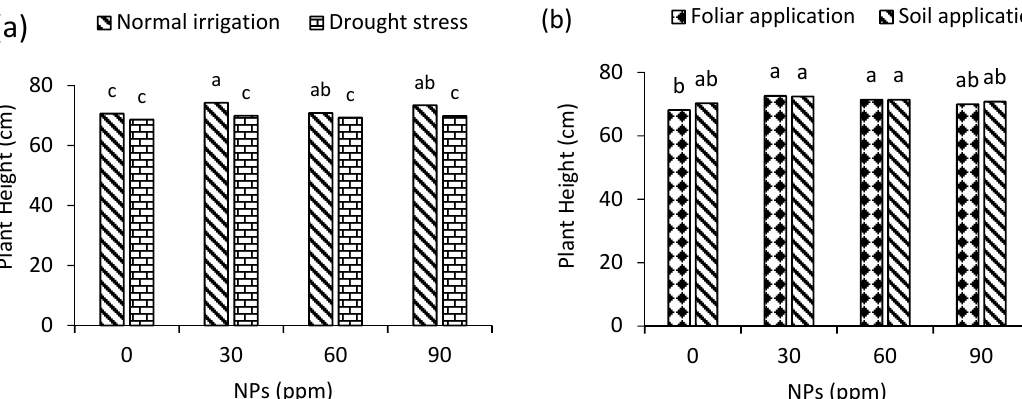
Fig 8. The effect of NPs concentration, irrigation regime and application method on plant height. Means by the uncommon letter in each column are significantly different according to Duncan test